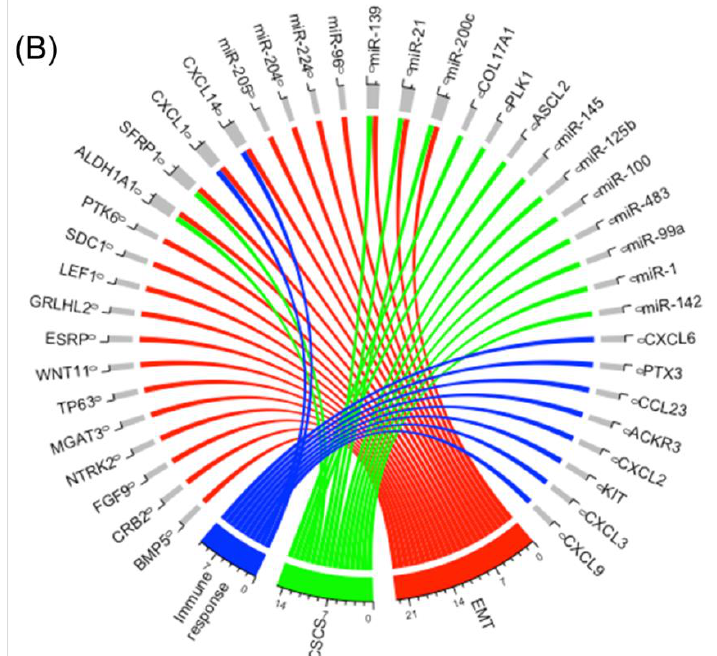
Figure 7. Common and specific transcripts of EMT and CSCs related to the BRCA overall survival. ( A ) A Venn diagram of EMT and CSC transcripts predicting the overall survival, and ( B ) a Circos representation of transcripts predicting the overall survival rate involved in the immune response, CSCs, and EMT.